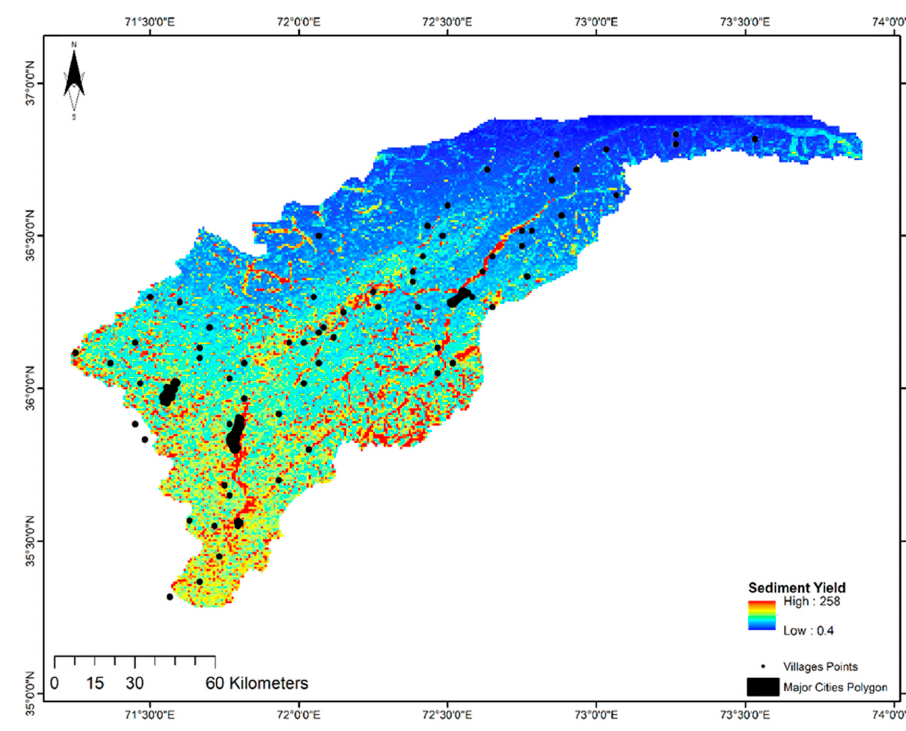
Figure 5. District map for sediment yield.